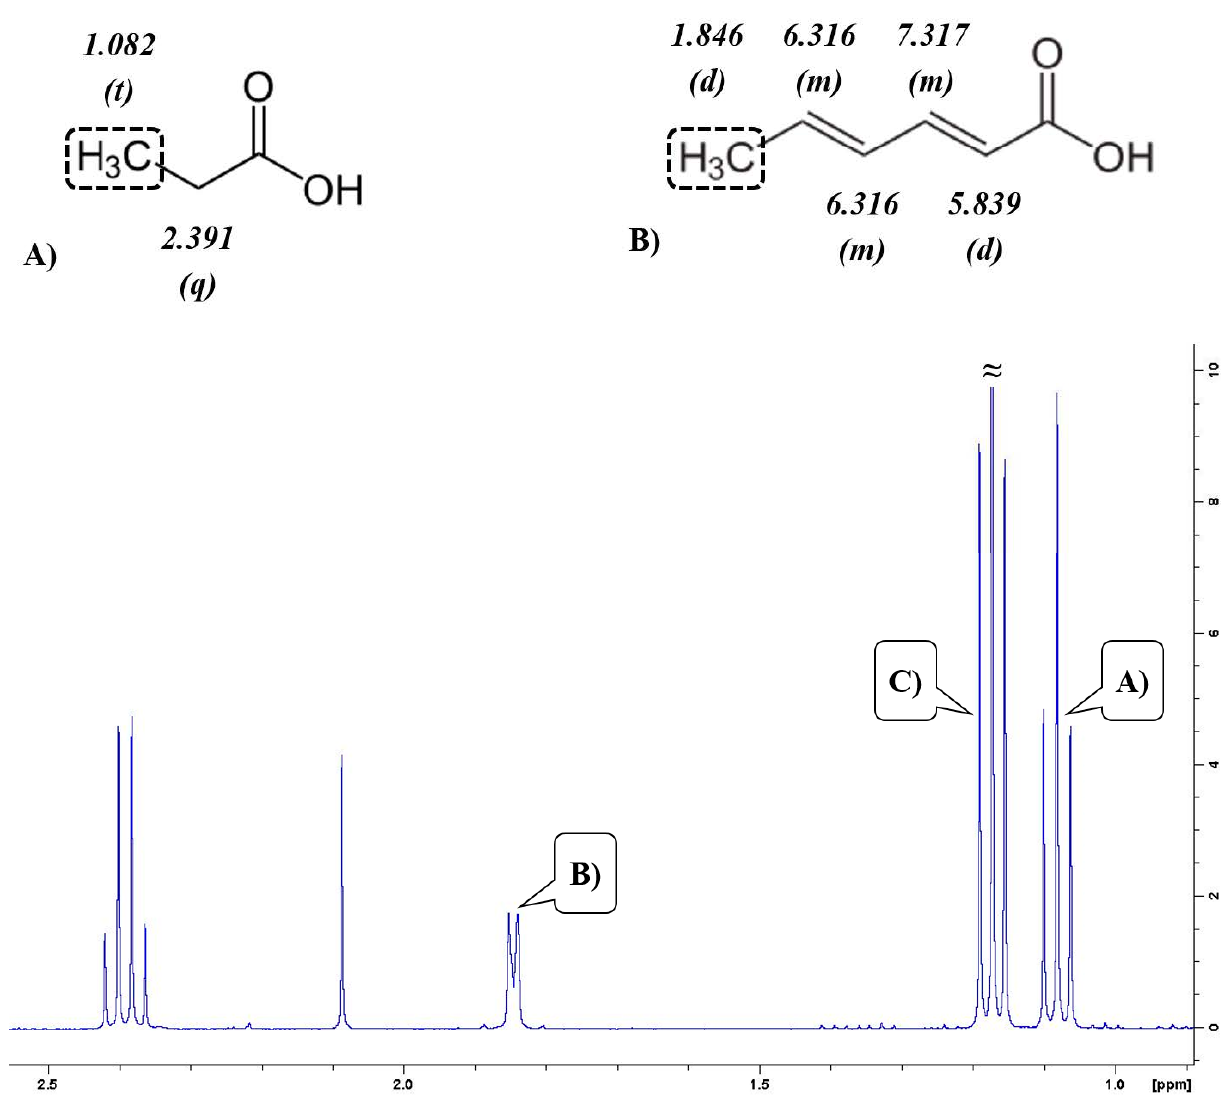
Figure 1. Structural formula of ( A ) propionic acid, ( B ) sorbic acid (upper panels) and assignment of 1 H-NMR signals of A) propionic acid, B) sorbic acid, and C) ethanol–CH 3 , with top of triplet cut off (lower